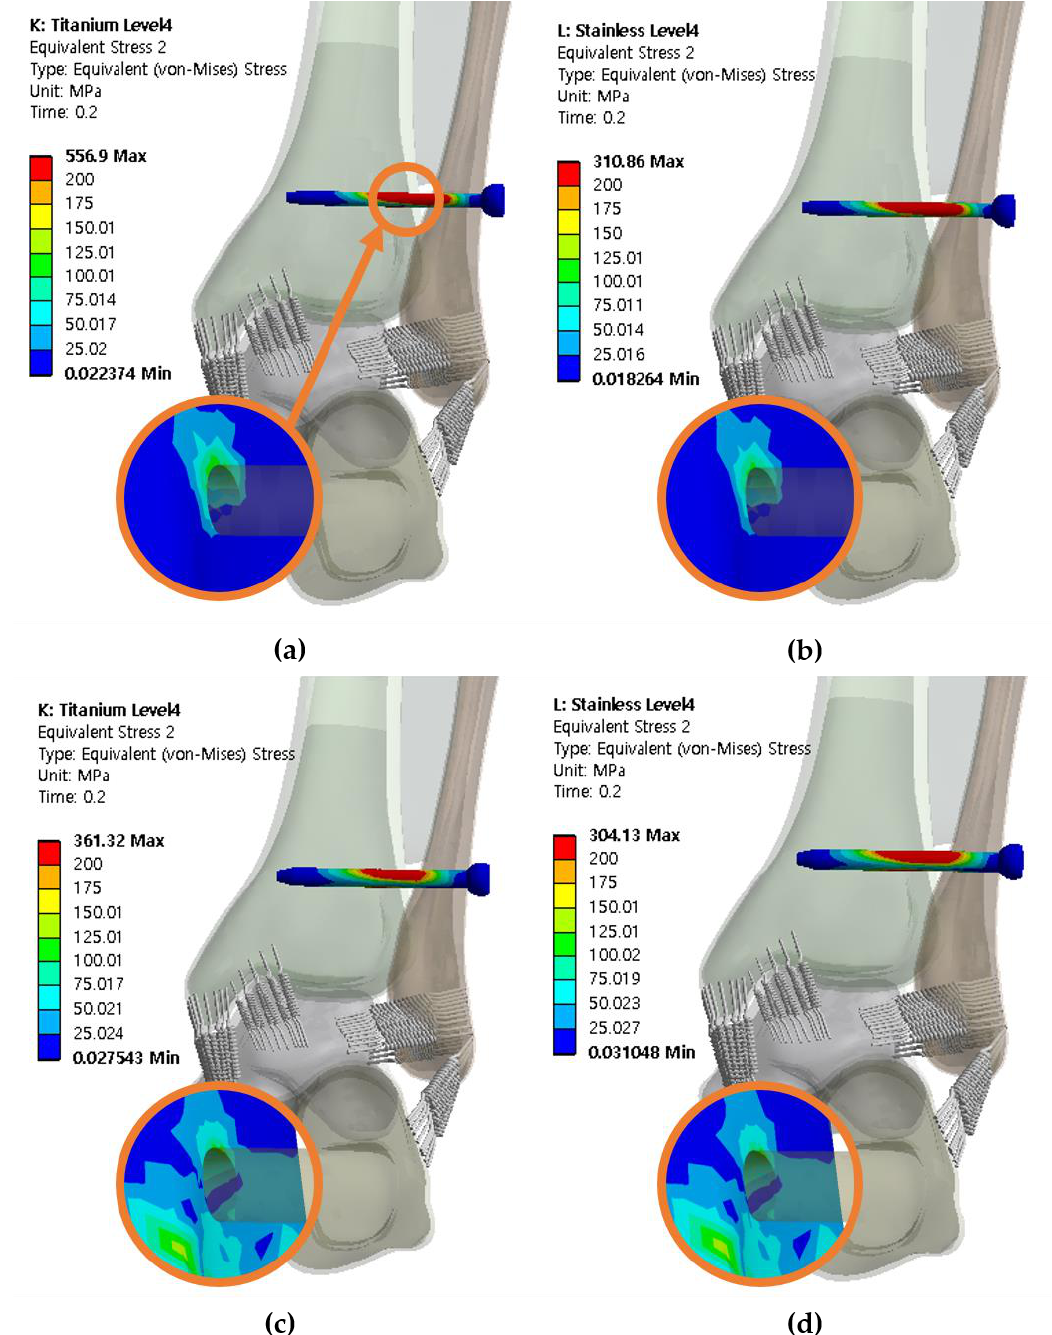
Figure 4. The von Mises stresses of the syndesmotic screw and adjacent bone at screw level of 25 mm with three cortical bones purchased: ( a ) titanium screw with a diameter of 3.5 mm, ( b ) stainless steel screw with a diameter of 3.5 mm, ( c ) titanium screw with a diameter of 4.5 mm, ( d ) stainless steel screw with a diameter of 4.5 mm.